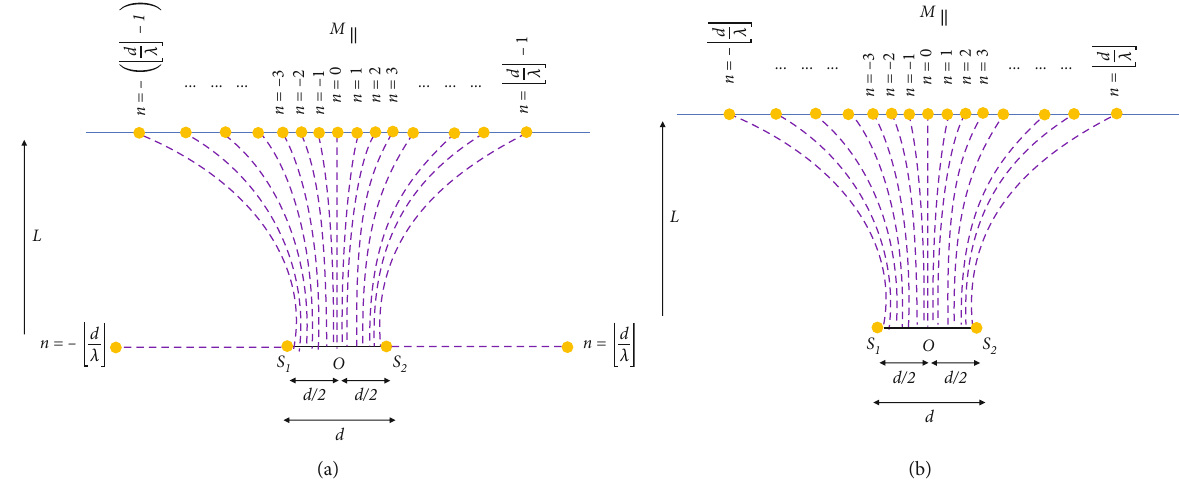
S 1 2 (black line) is the screen midpoint. jj